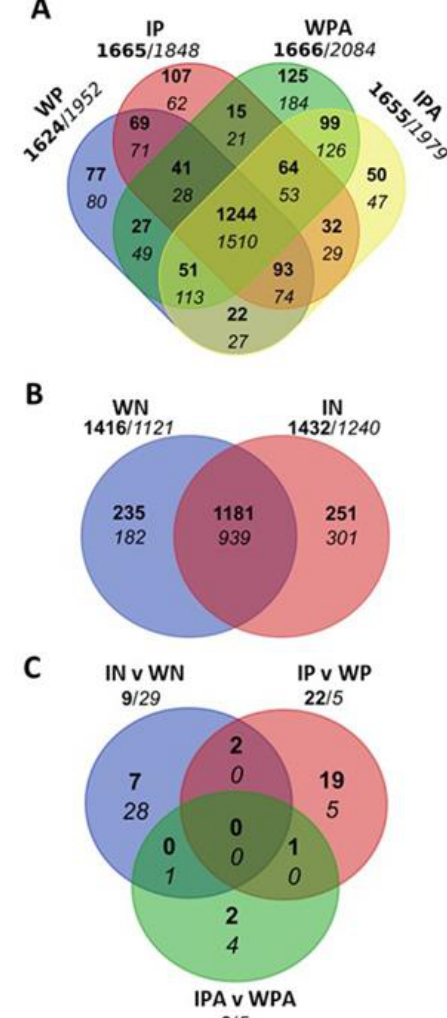
Figure 3. Venn diagrams of the up-(bold numbers) and down-regulated (regular numbers) genes in several comparisons (DEG, edgeR, BH p - value adjustment α ≤ 0.05). All the induced and repressed DEGs met a cutoff of |Log 2 FoldChange| ≥ 1. ( A ) The number of the up- and down-regulated genes of the infected Pinalate (IP) fruit and its respective wounded controls (WP), plus those DEGS of the infected Pinalate fruit treated with ABA (IPA) and their control (WPA), compared to the freshly-harvested (FH) Pinalate fruit; ( B ) The number of the up- and down-regulated genes in the wounded (control) (WN) and infected Navelate (IN) fruit compared to the FH Navelate fruit; ( C ) The number of the up- and down-regulated genes by infection in relation to wounding (control) in the Pinalate, Pinalate + ABA and Navelate samples. The numbers outside of the diagrams are the sum of all the induced and repressed genes under each condition. The infected fruit were inoculated with 10 4 P. digitatum conidia mL −1 and the control mock-wounded fruit with water. After wounding or infection, all the fruit were kept at 20 °C for 1 d (1 dpi).